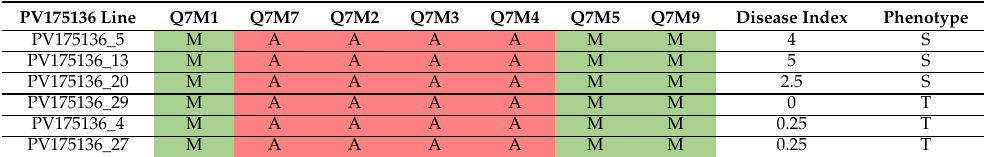
Table 2. CAPS markers analysis of the QTL on chromosome 7 in line PV175136. In the table, a number of plants with segregating phenotypes is given. A = homozygous for S. arcanum LA2157 allele, M = homozygous for S. lycopersicum cv. MM, S = susceptible, T = tolerant. PV175136 Line